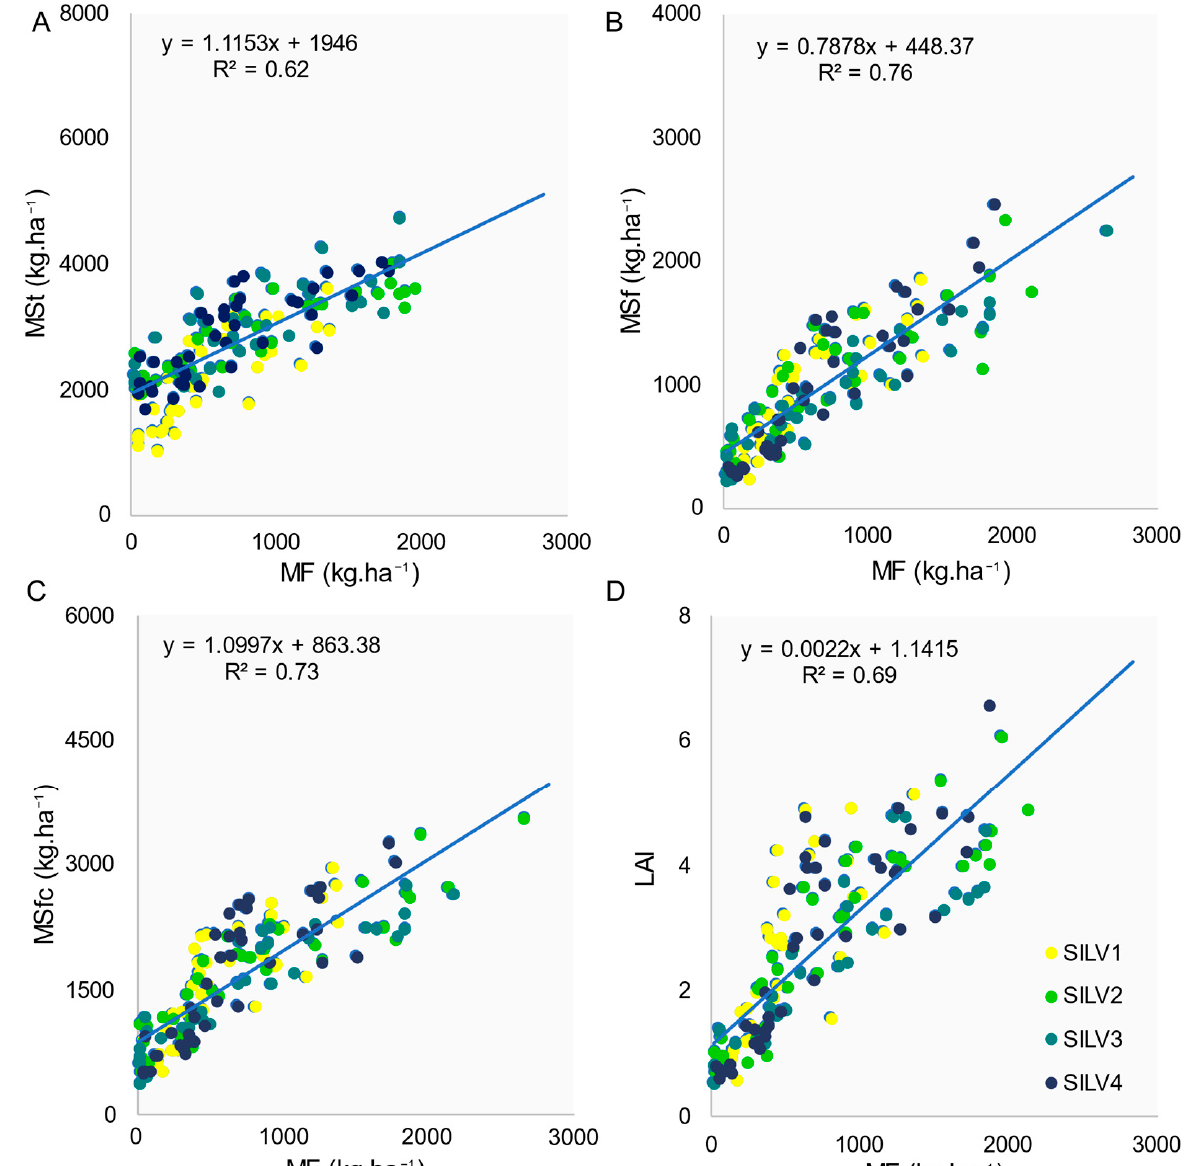
Figure 7. SAFER estimated fresh mass (MF) and the Piatã grass pasture variables linear regression in the SILV system. ( A ) total dry mass (MSt); ( B ) dry mass of leaves (MSf); ( C ) leaf and stem dry mass (MSfc); ( D ) leaf area index (LAI).